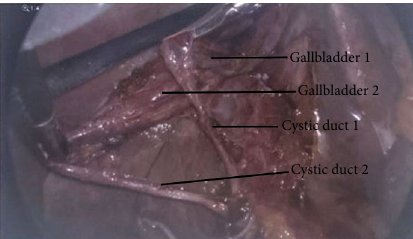
Figure 5: Two separate gallbladders with two separate cystic ducts after further dissection.